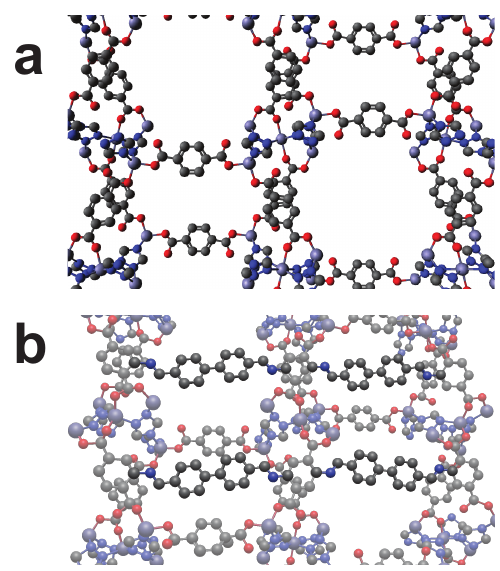
Figure 6. The MOF “IBUBIT” can be cross-linked by using cross-linker CL2. ( a ): Unmodified view of IBUBIT. ( b ): Cross-linked IBUBIT. Color code: Black (C), Blue (N), Red (O), Purple (Zn). Hydrogens omitted for visibility.